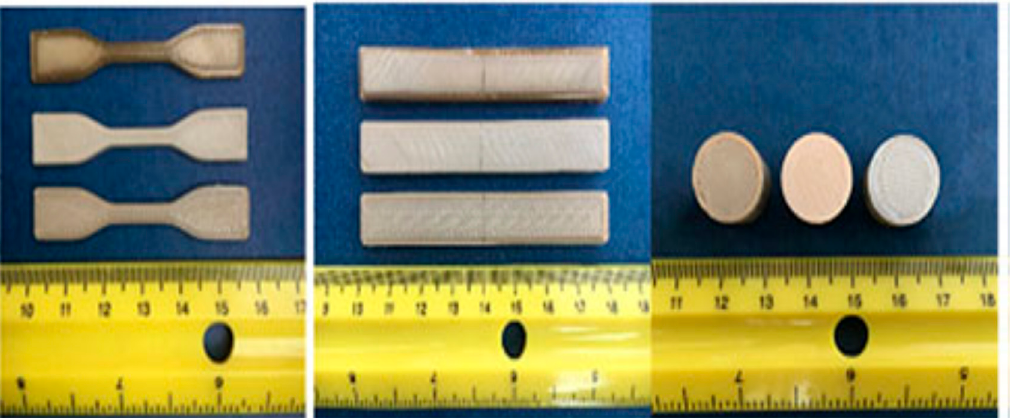
Figure 10. Colour di ff erences in PEEK samples (Hyrel, Intamsys, and Indmatec from top to bottom or from left to right, respectively) [90].